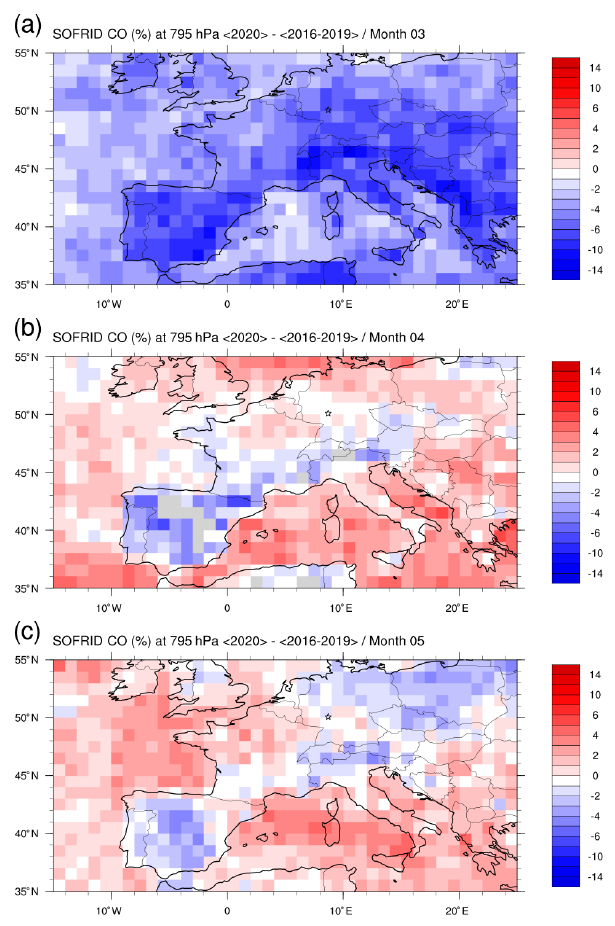
Figure 15. Percentage change of IASI-SOFRID carbon monoxide at 795hPa in (a) March, (b) April and (c) May 2020 compared with the reference average period of 2016–2019.